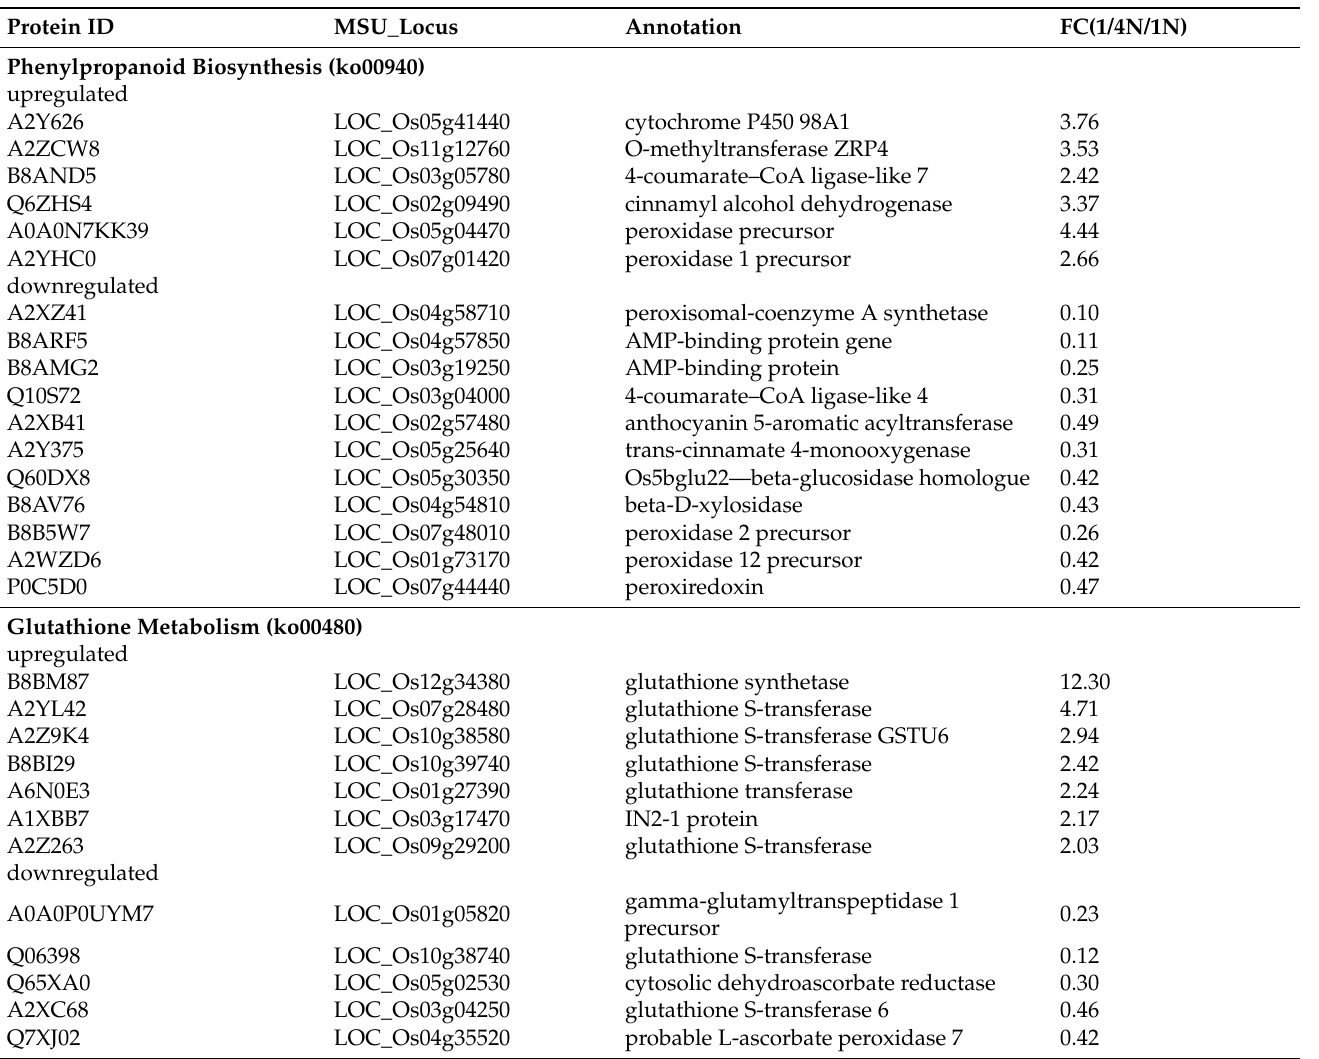
Table 2. The DAPs involved in phenylpropanoid biosynthesis and glutathione metabolism pathway in 1/4N_1N comparison. Protein ID MSU_Locus Annotation